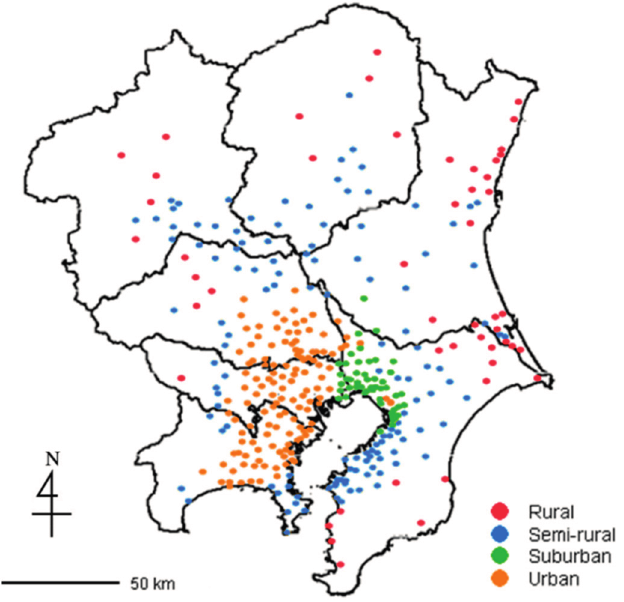
Figure 3. Geographic mapping of four groups of constant ambient air monitoring stations.